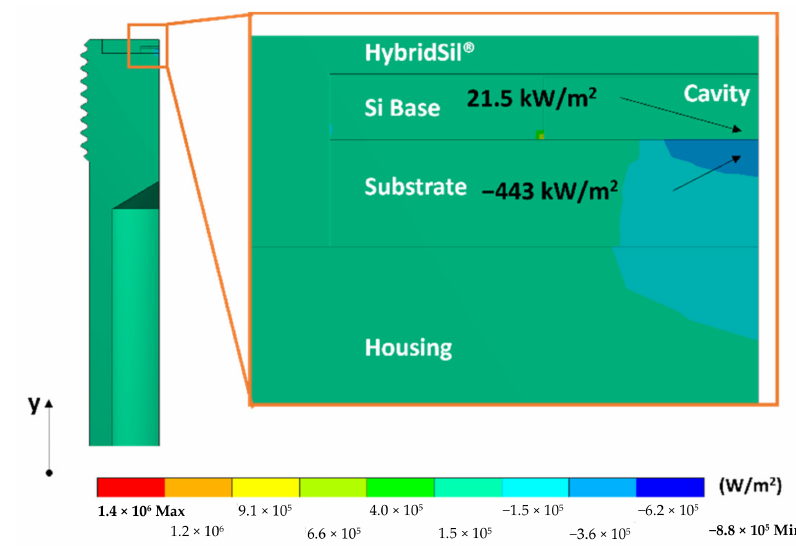
Figure 8. Heat flux contour plot in the vertical (y) direction.